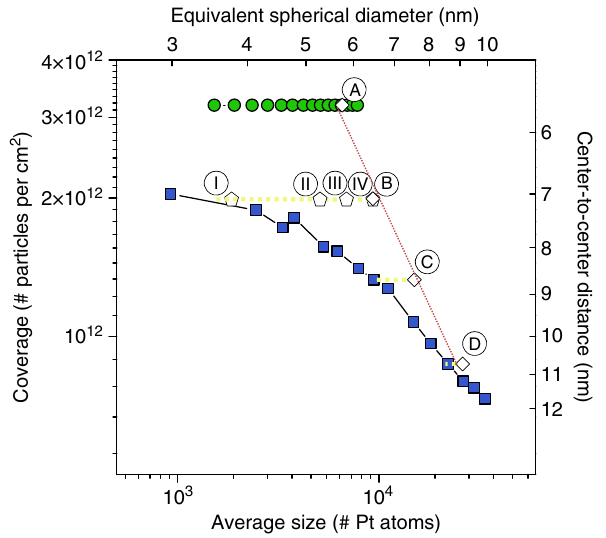
Fig. 9 Precise control of coverage and size of Pt nanoparticles using ALD. Average particle coverage against particle size for samples A, B, C, and D (see also Fig. 6) and I, II, III, and IV (see also Fig. 7), together with the in situ measured data for the O 2 -based (blue squares) and N 2 * -based (green circles) Pt ALD processes. The dashed yellow and red lines serve as guides to the analysis of the GISAXS patterns are indicated and schematically represented in Fig. 7c (GISAXS analysis details and simulated patterns may be found in Supplementary Note 2 and Supple- mentary Fig. 11). The values for the average particle width obtained for samples II and IV are in good agreement with particle size distributions derived from high angle annular dark fi eld (HAADF) scanning transmission electron microscopy (STEM) images (Fig. 8). The combined GISAXS and electron microscopy analysis thus con fi rms the capability of ALD to tailor the average Pt particle size with sub-nanometer precision while keeping the particle areal density constant.